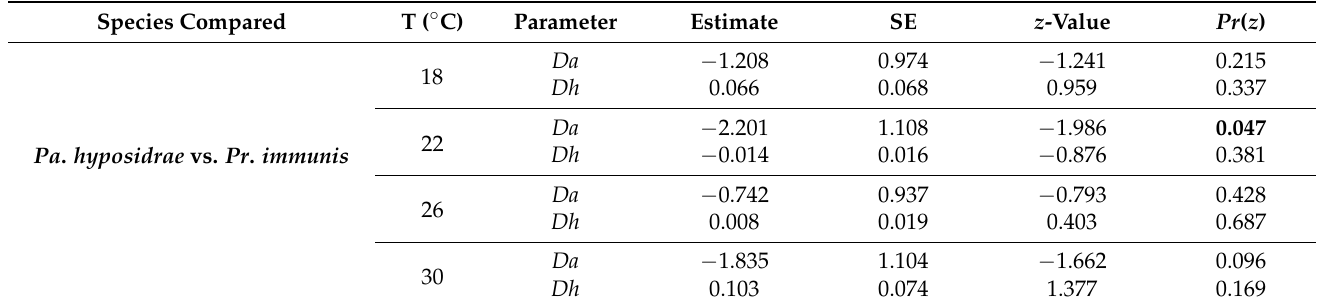
Table 2. Estimates of the differences in parasitic rate ( Da ) and handling time ( Dh ) between Pa. hyposidrae and Pr. immunis under four